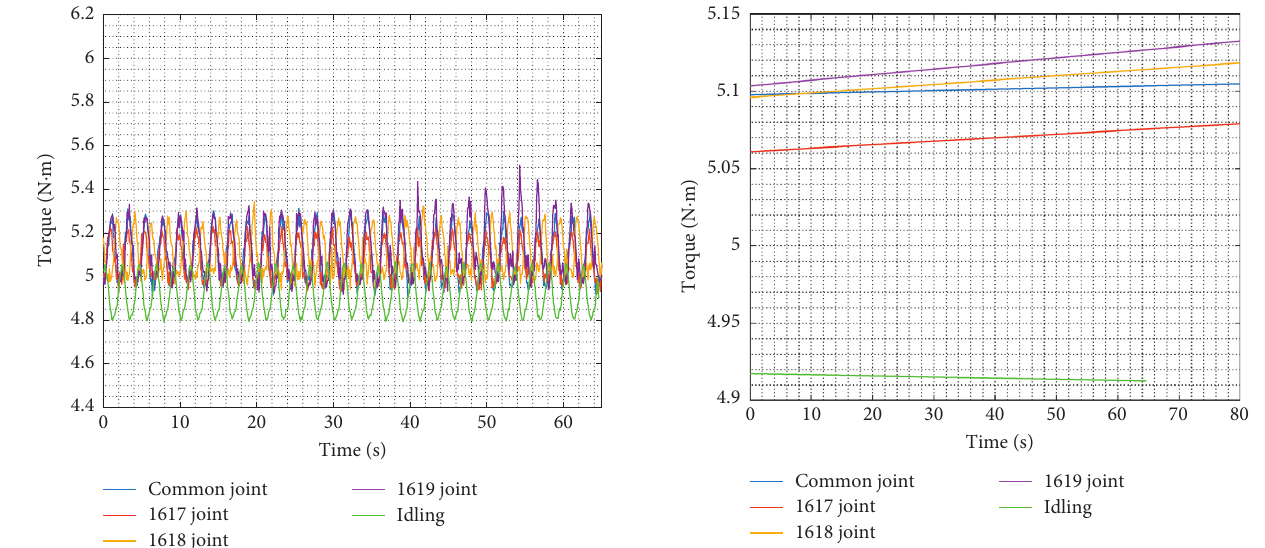
Figure 3: Torque-time curves with a rotation speed of 30r/min and a penetration rate of 18m/h.